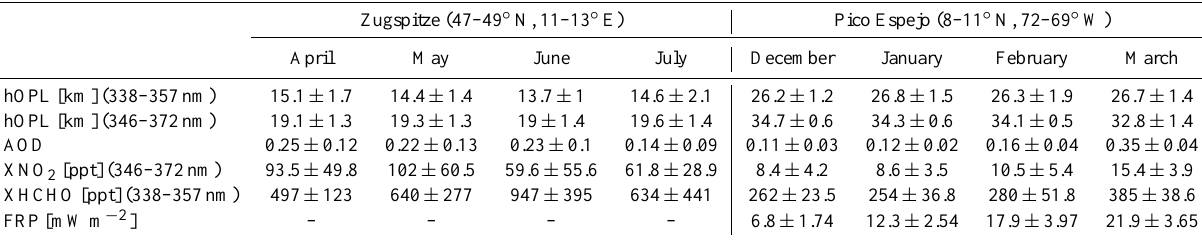
, and X HCHO as estimated from the high-altitude MAX- Table 3. Arithmetic mean and standard deviation of the parameters hOPL, X NO 2 DOAS measurements as well as aerosol optical depth (AOD) and fire radiative power (FRP) from MODIS on board Terra and Aqua satellites. Both AOD and FRP are averages over monthly means obtained from MODIS on board Terra (10:30LT) and Aqua (13:30LT) satellites. The standard deviation of daily and monthly means is given for Zugspitze and Pico Espejo, and the numbers in brackets are latitude and longitude as defined for the regions selected for spatially averaging AOD and